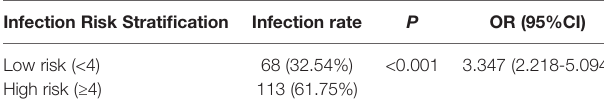
TABLE 4 | Comparison of incidence of subsequent infection after CR-GNB colonization in different risk strati fi cation groups. Infection Risk Strati fi cation Infection rate P OR (95%CI) Low risk